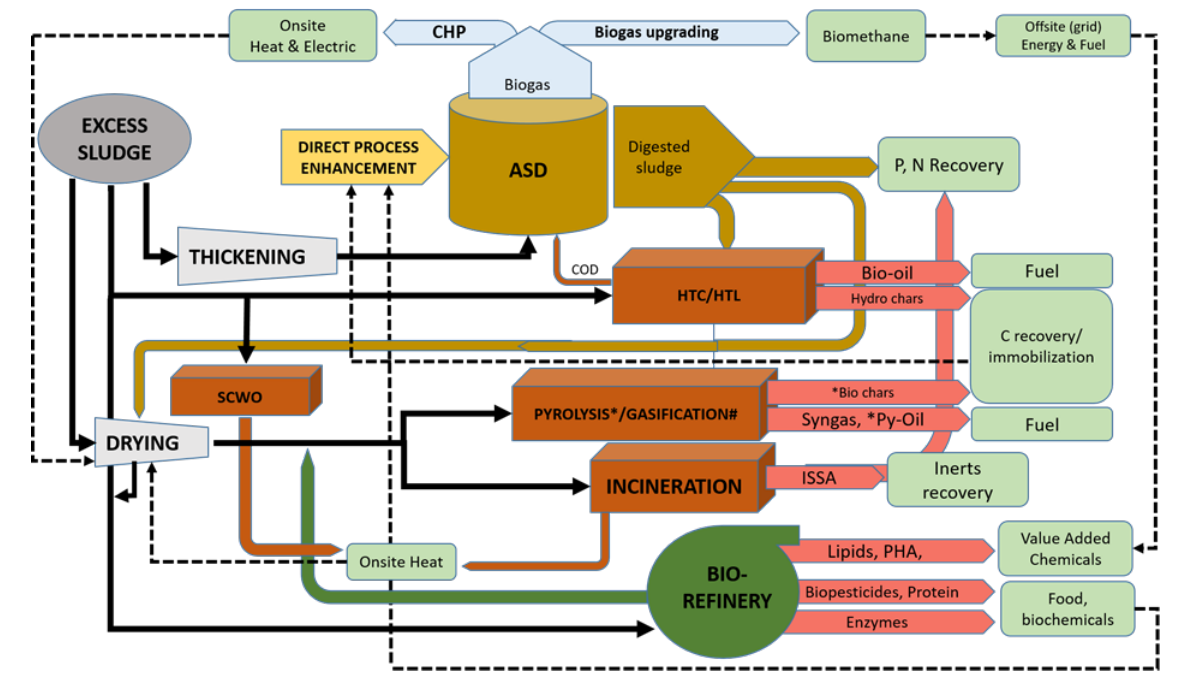
Figure 4. Possible process technologies interconnections in an integrated, circular economy-based sludge management strategy.